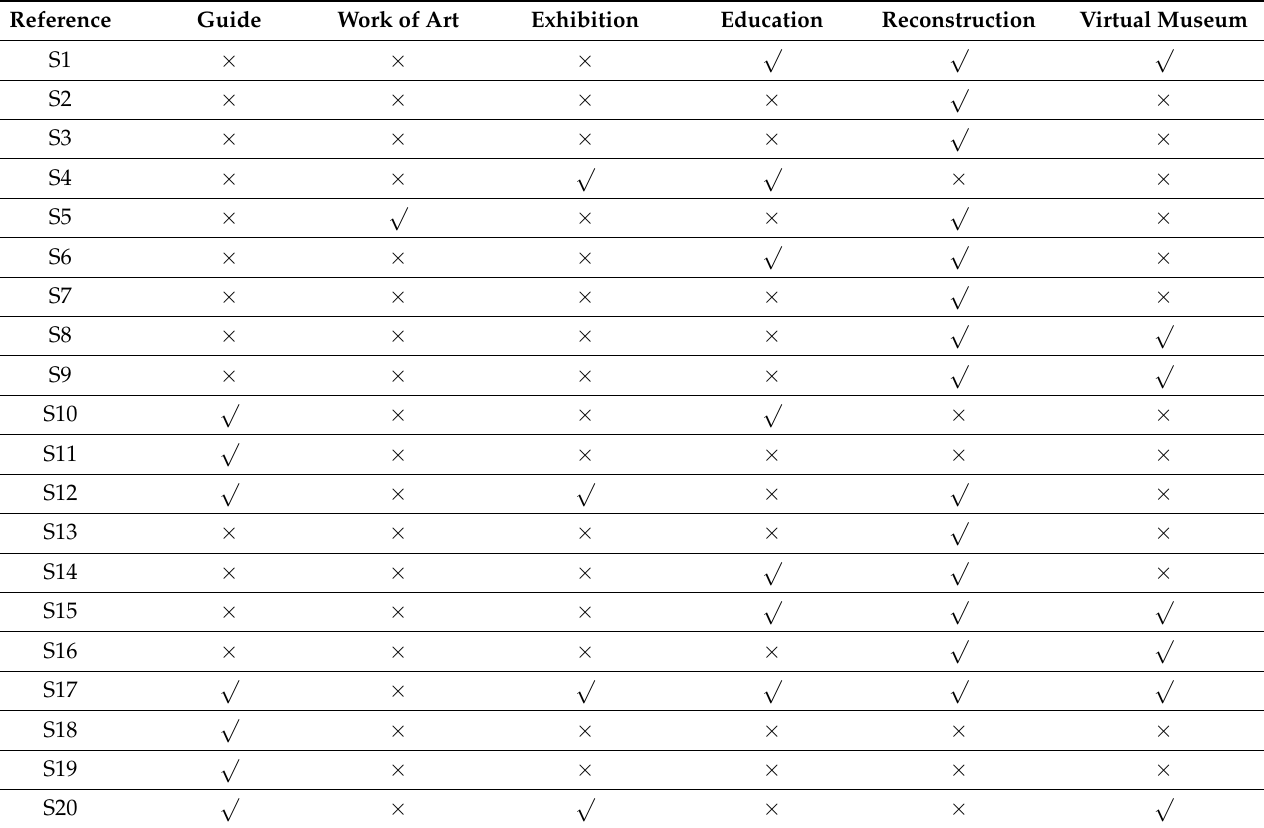
Table 3. Identification of the categories in which the papers in Table 2 can be included. Reference Guide Work of Art Exhibition Education Reconstruction Virtual